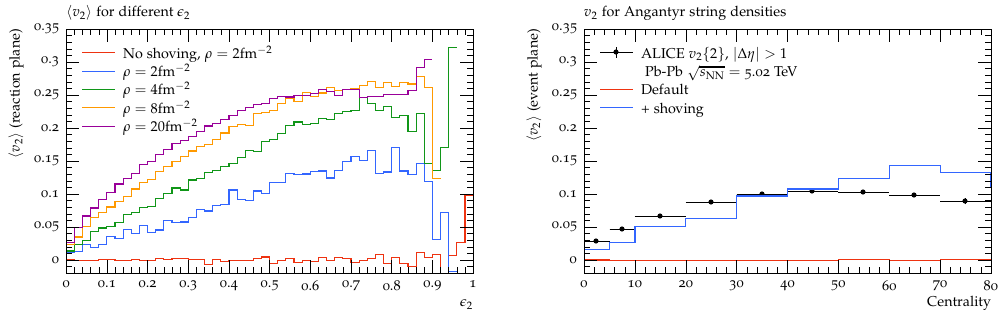
Figure 9 . The average v 2 flow coefficient for different constant densities as function of (cid:15) 2 (left), and v 2 as function of centrality with string densities from Angantyr (right). Data from ALICE [86] added to guide the